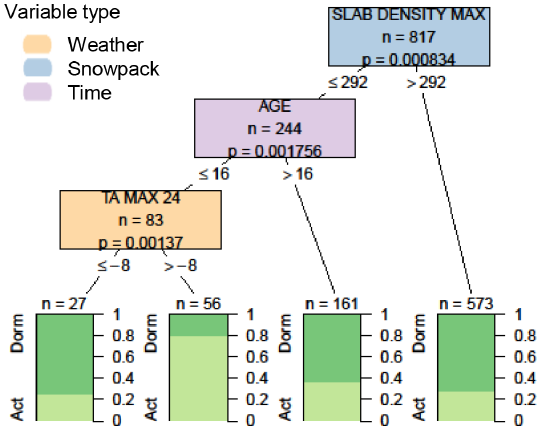
Figure 9. Decision tree comparing conditions before and after weak layers become dormant (considering the first 14d when layers are no longer associated with persistent problems with the last 14d when they are associated with persistent problems). Variables ap- pearing in the tree include the maximum slab density in kgm − 3 (SLAB DENSITY MAX), the age of the weak layer in days (AGE), and the maximum air temperature over the past 24h in ◦ C (TA MAX 24). Terminal nodes show the proportion of cases with weak layers having active (light green) and dormant (dark green)